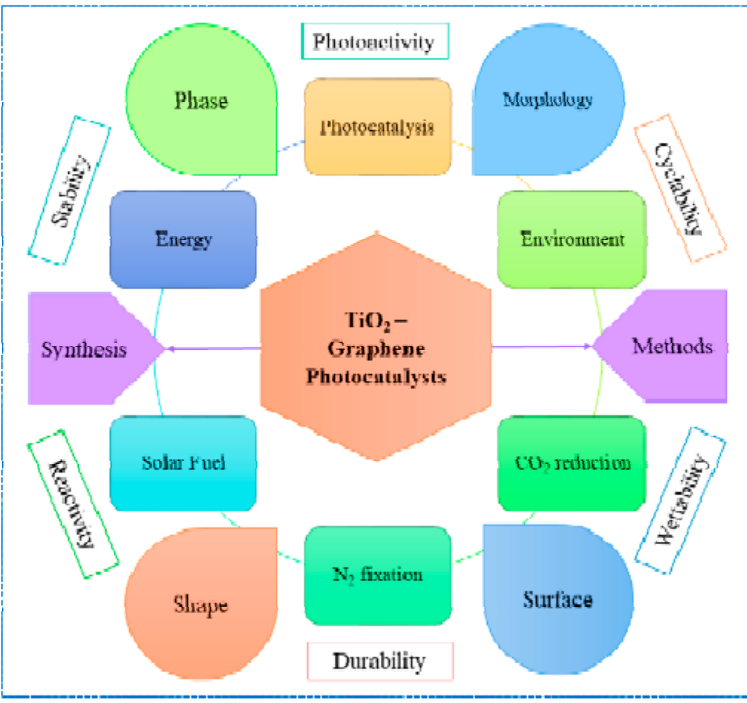
Figure 11. S chematic representation of titania–graphene composites. Figure 11. Schematic representation of titania–graphene